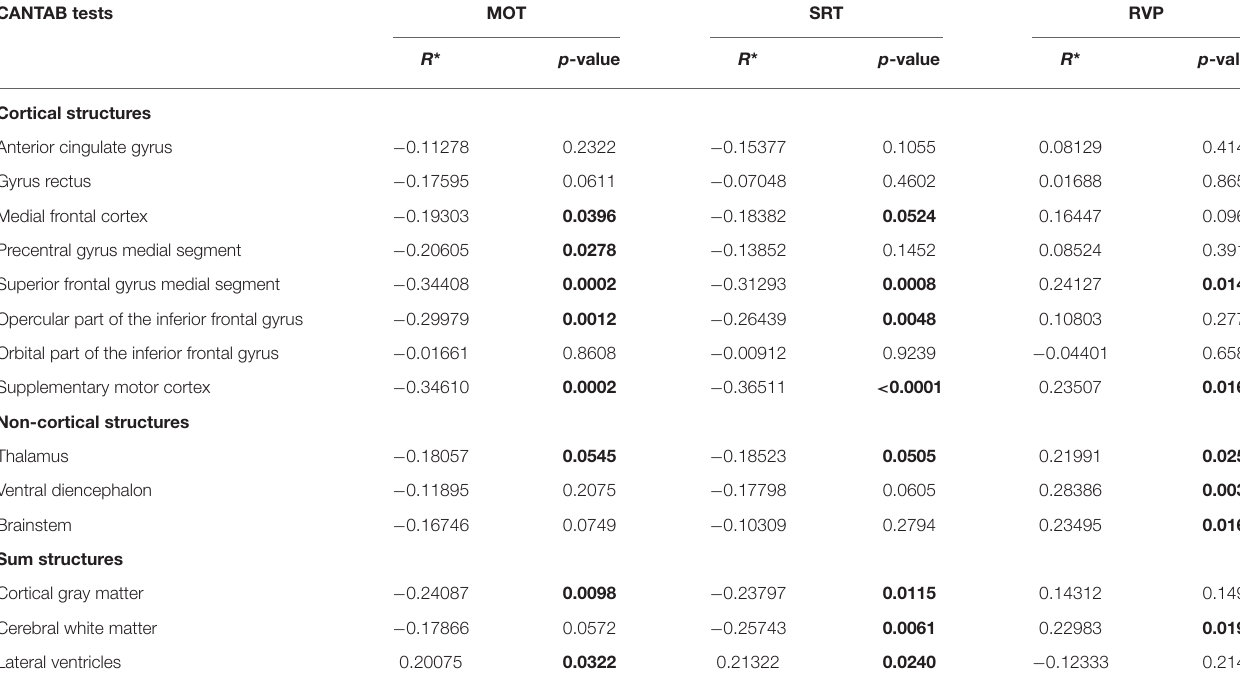
TABLE 4 | CANTAB results correlation to atrophy rate by Spearman correlation coefficient. CANTAB tests